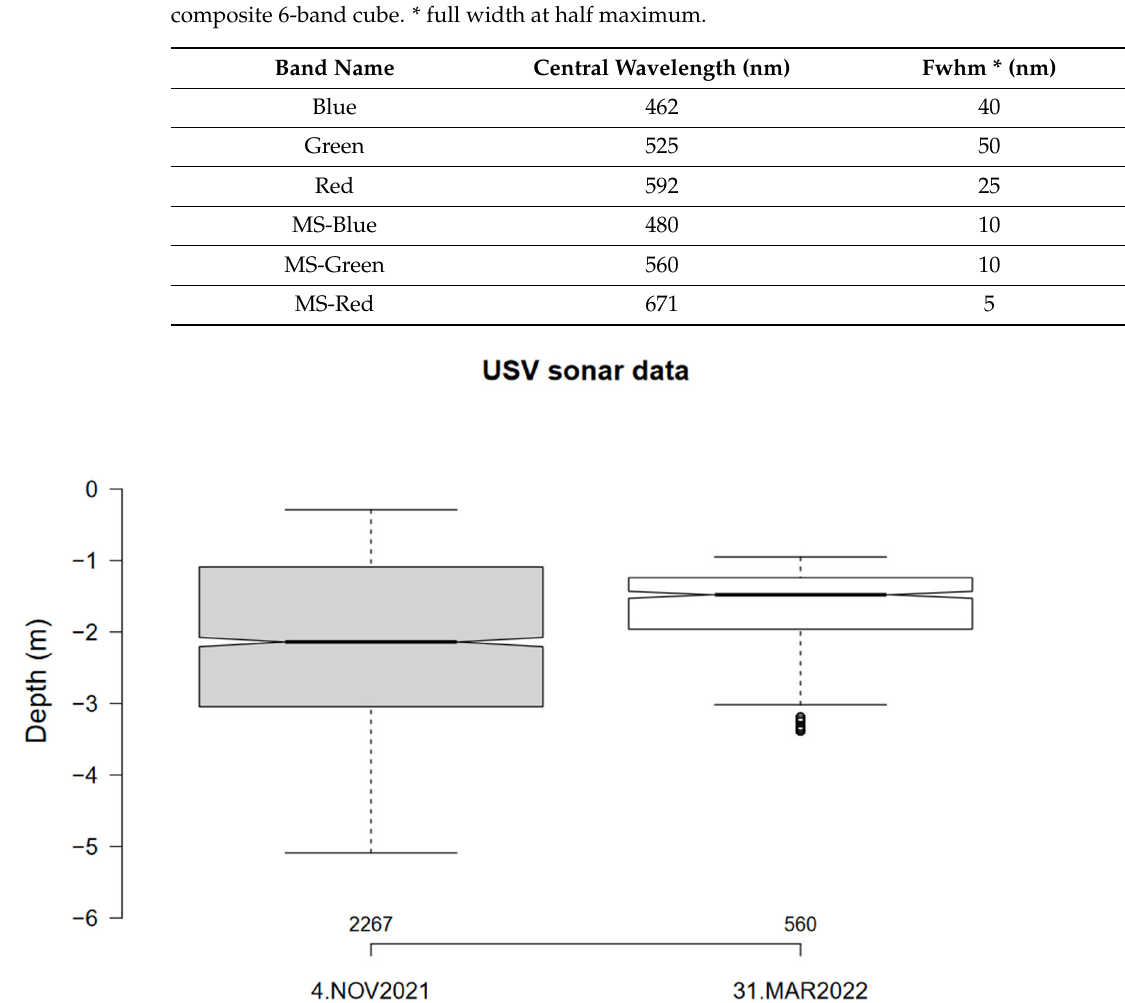
Figure A1. Boxplots of the sonar depth measurements collected at each survey. The black horizontal line inside each box indicates the median value of each sample and the numbers at the horizontal axis indicate the number of measurements.